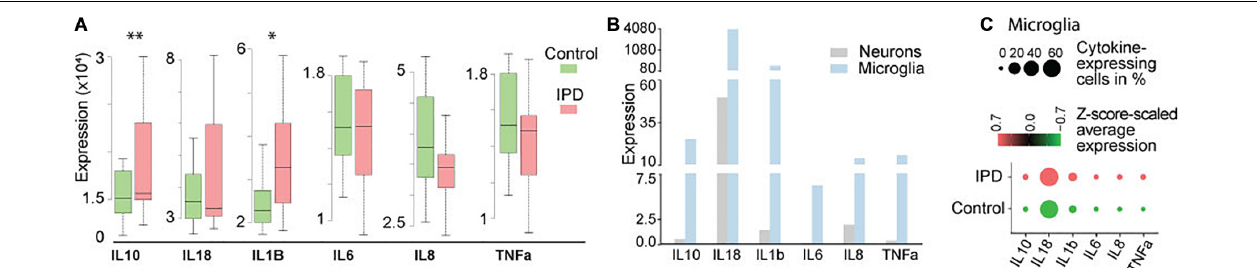
FIGURE 1 | Cytokine expression in bulk RNA-seq and single-nuclei RNA-seq datasets. (A) Bulk analysis of SN tissue displays higher expression of IL1B and IL10 in IPD ( FDR = 0.023; FDR = 0.0067). (B) Single-nuclei analysis of the human midbrain shows that the overall expression of cytokines is higher in microglia (3903 cells) than in neurons (5314 cells). (C) Cytokines are expressed in a large number of IPD and control microglia. Z-score-scaled average expression per cluster shows higher levels in IPD compared to control microglia. “ DotPlot ” function (Seurat package) was used to visualize expression and percentage of cytokine-expressing cells. ∗ p < 0.05; ∗∗ p < 0.01; IPD, idiopathic PD.